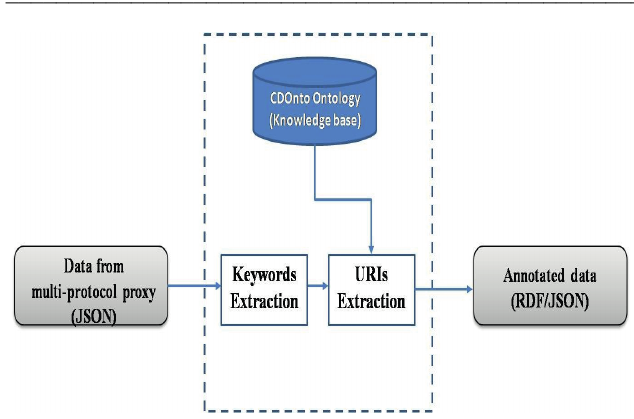
Fig. 4. Semantic annotation for sensor data.